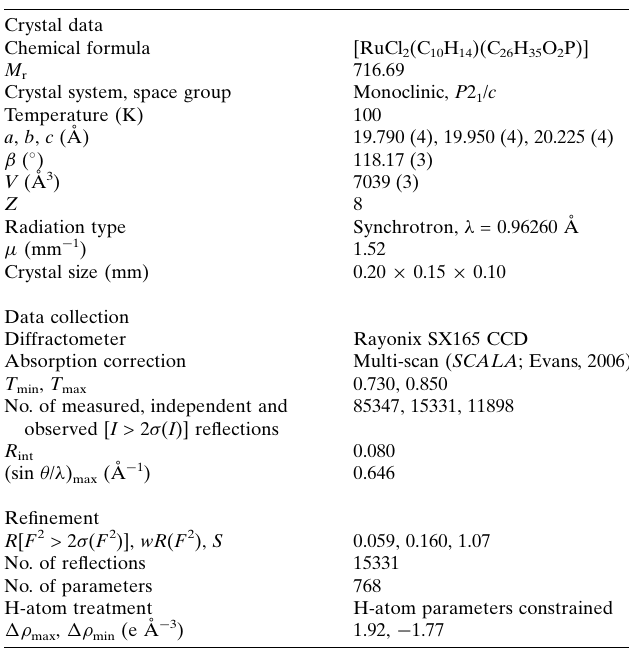
Crystal data Chemical